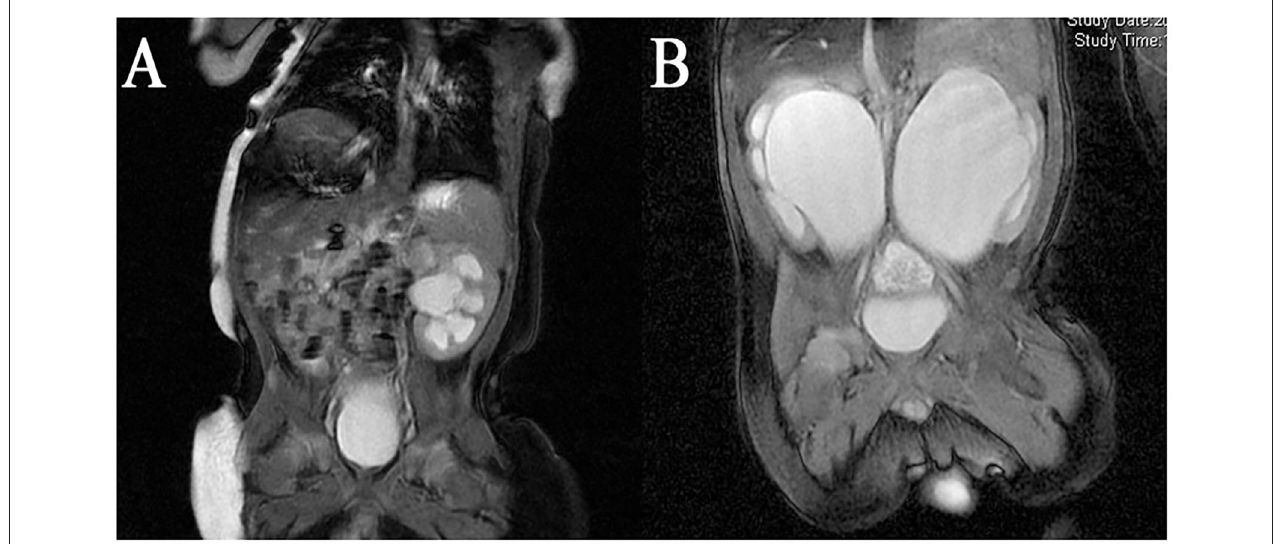
FIGURE 1 | MRI result of a (A) Unilateral UPJO with contralateral renal dysplasia; (B) bilateral severe